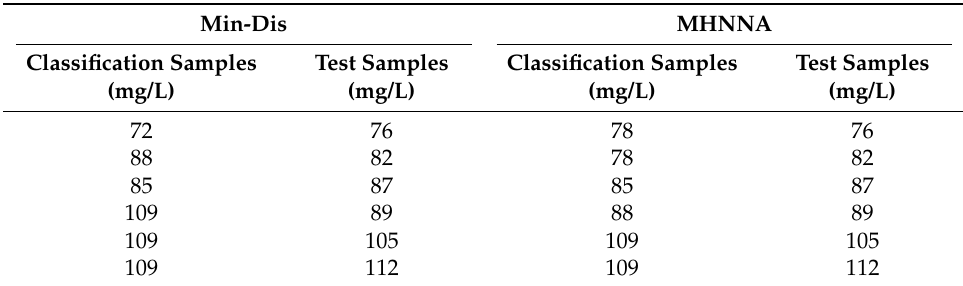
Table 6. The sample accuracies of the classes produced by MHNNA and Min-Dis.